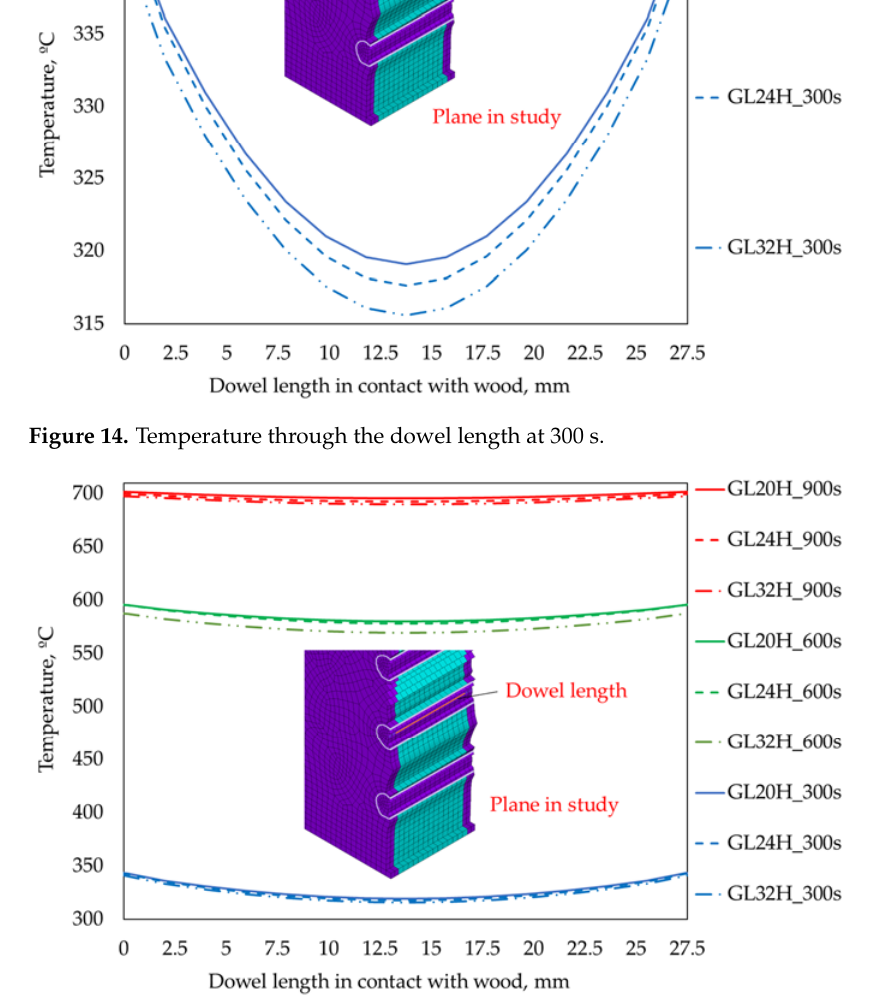
Figure 15. Temperature through the dowel length at 300, 600, and 900 s.